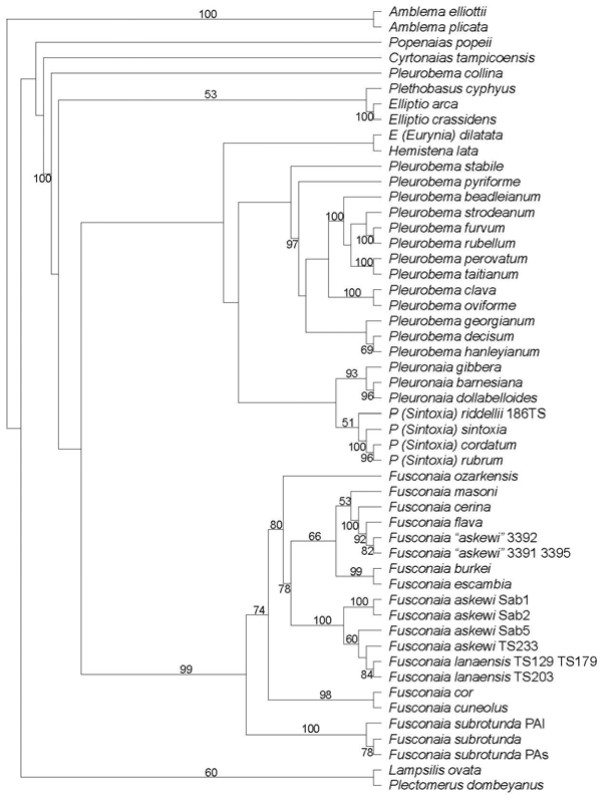
Strict consensus cladogram, combinedcox1andnad1data, with jackknife percentages shown if over 50%. See text for discussion.